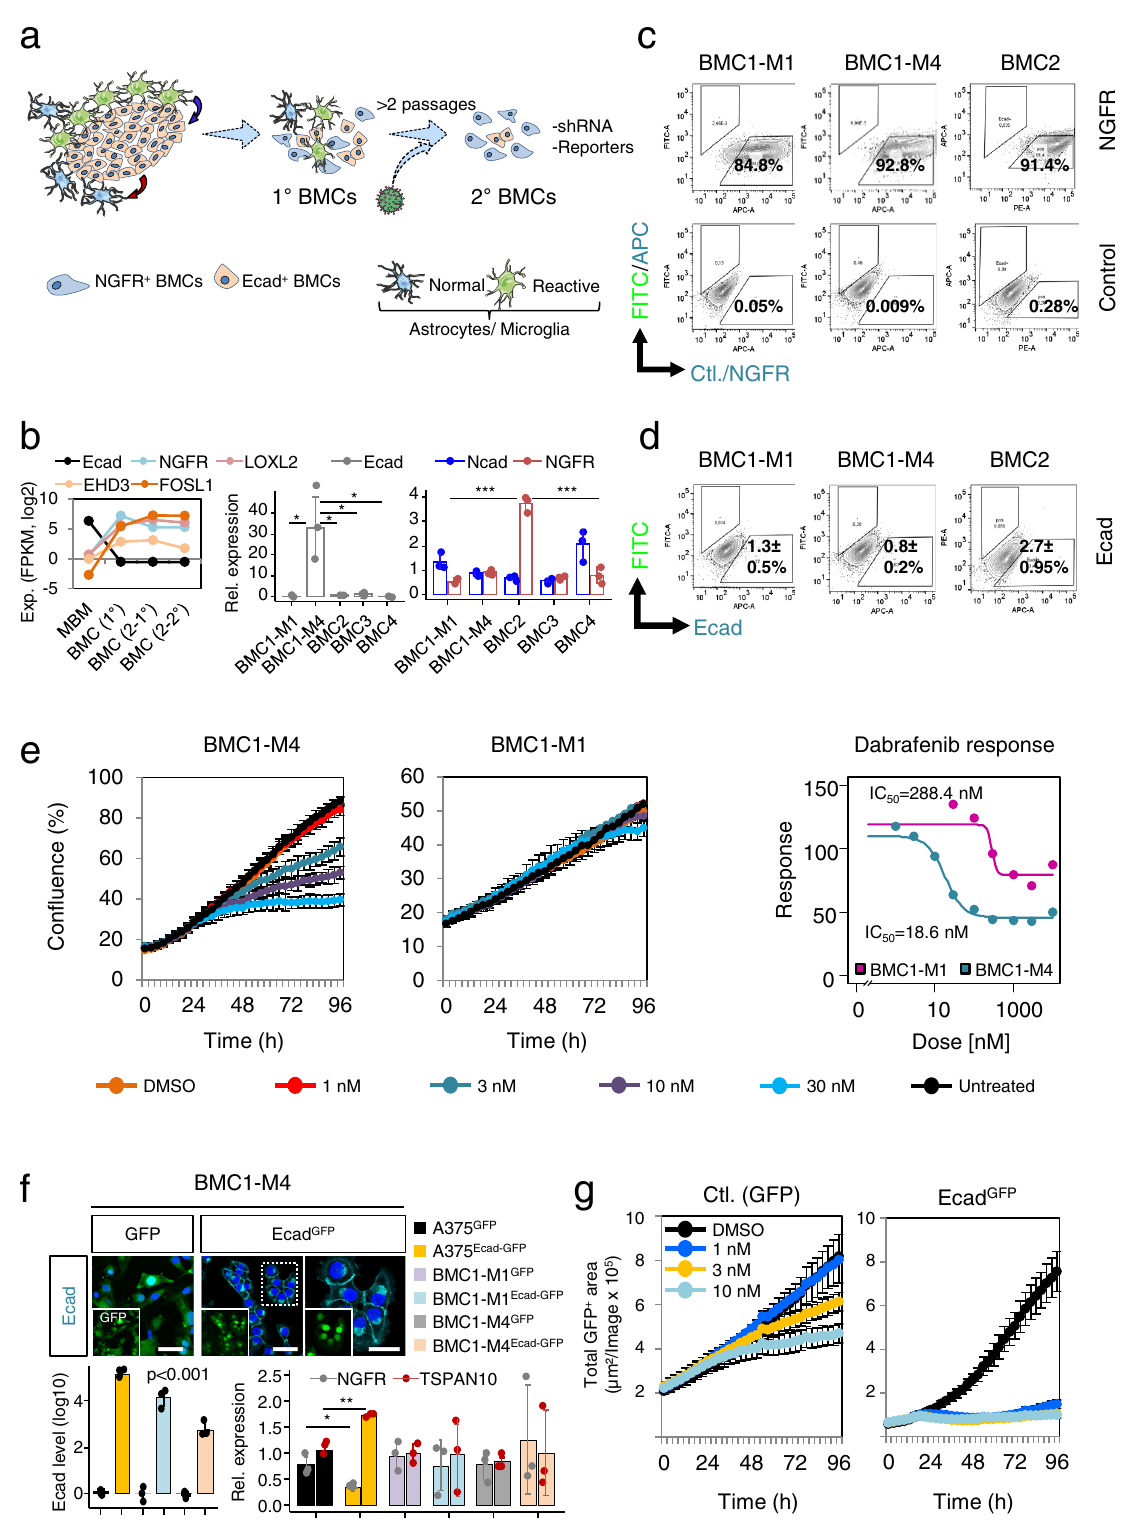
performed a KD of SOX4 in BMCs (BMC1-M4 and BMC4) and tracked changes in proliferation for 5 days (Fig. 7d, scheme). We observed that levels of NGFR and FOSL1 expression were not affected after 10d of DOX treatment in SOX4 KD cells (Fig. 7e, left panel), however cells exhibited a signi fi cant decrease in proliferation; BMC1-M4 ( p = 9.8e − 09; p =5.7e − 03) and BMC4 ( p =1.1e − 06; p =1.1e − 04) (Fig. 7e, center and right panels; Supplementary Fig. 10e center and right panels),